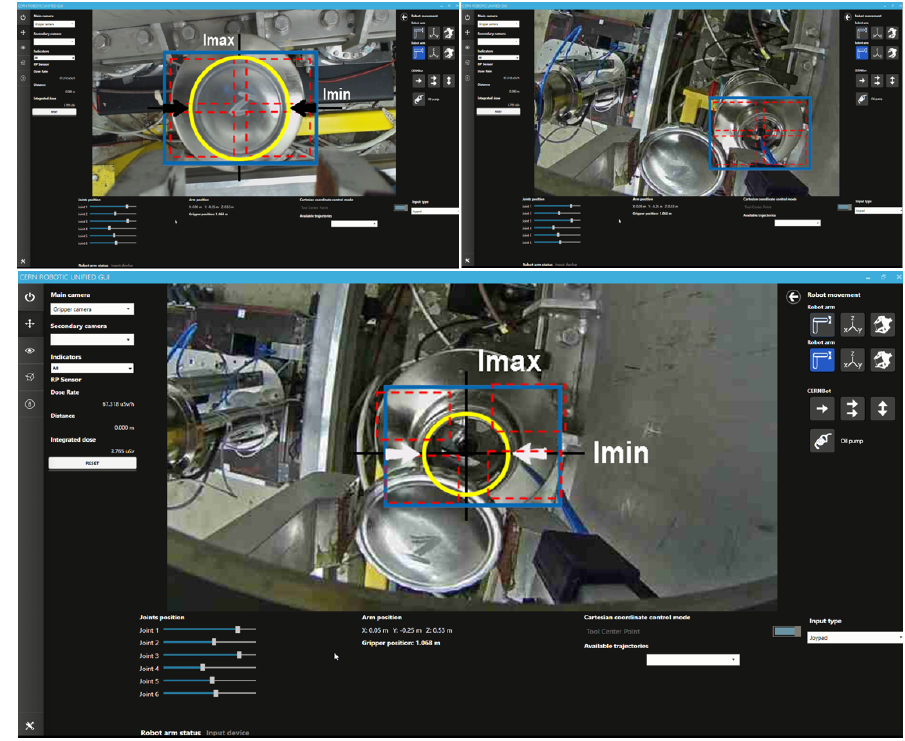
Figure 22. Grasping Determination calculation on a rounded and symmetric metallic object (radial